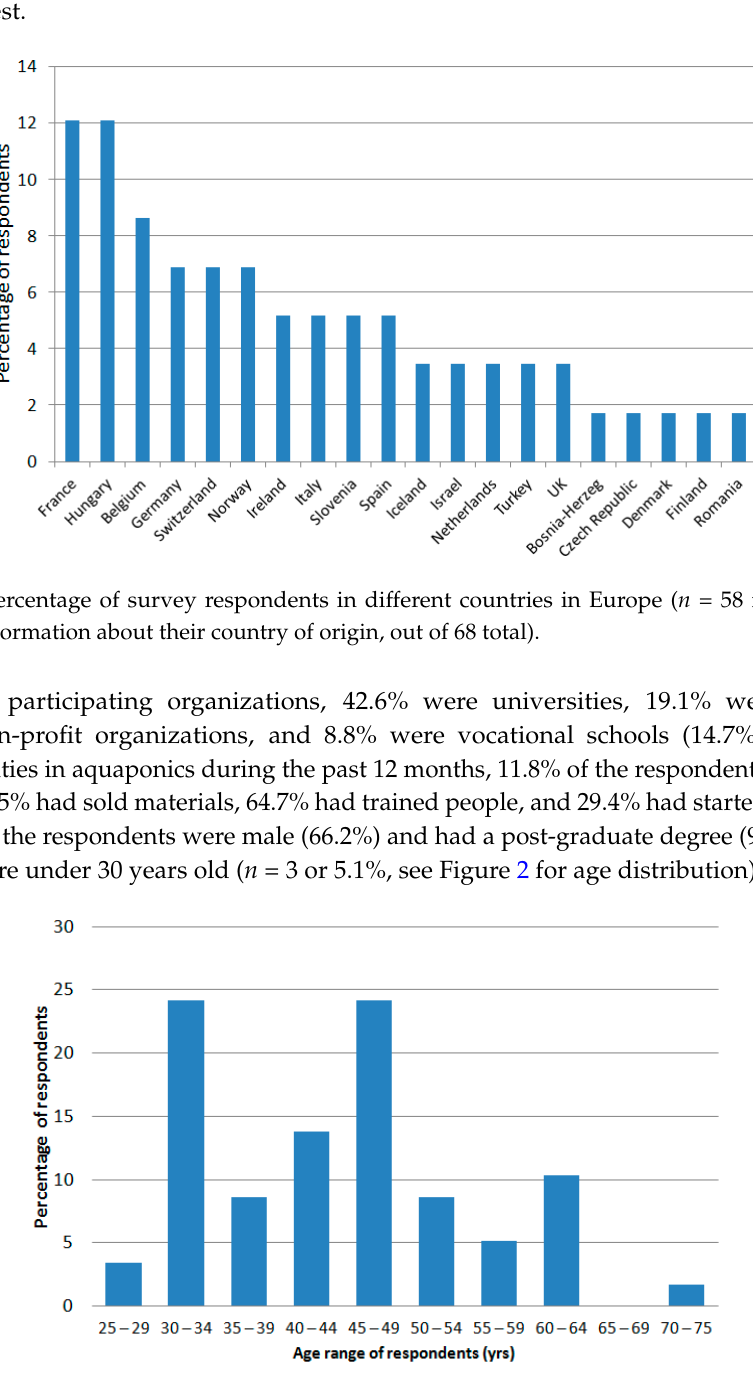
Figure 2. Percentage of age ranges of respondents to the survey in European aquaponics. The average age of the respondents was 44.5 ± 11.2 years old ( n = 59 respondents).